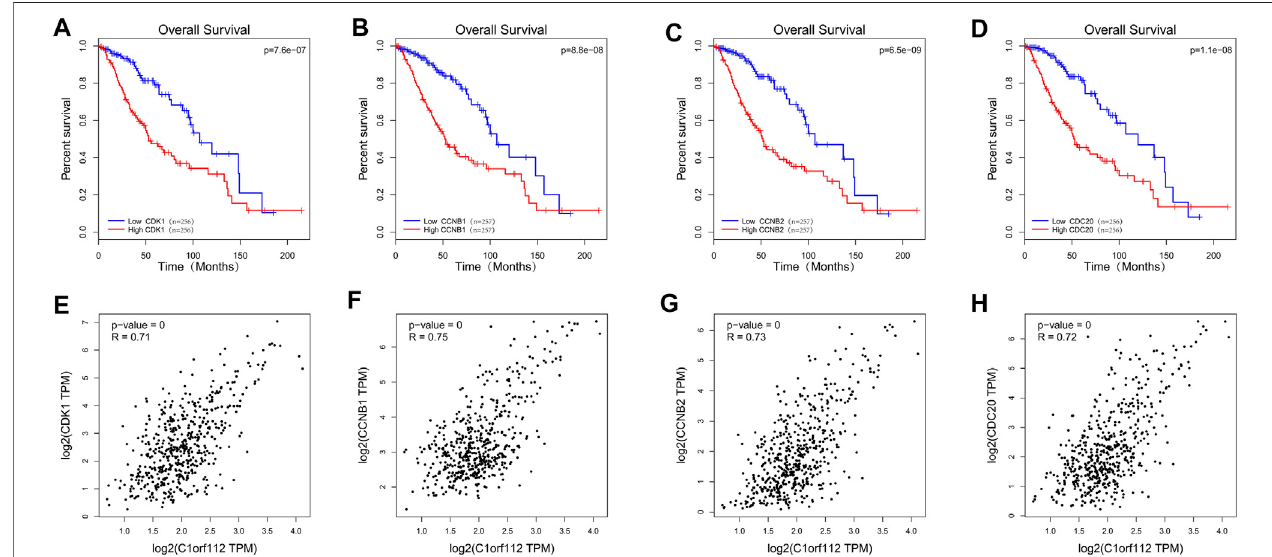
FIGURE 7 | The TCGA database was used to analyze the prognostic value and correlation of co-expressed genes. Survival curves of OS: (A) CDK1; (B) CCNB1; (C) CCNB2; (D) CDC20. Correlation between C1ORF112 and key co-expressed genes: (E) CDK1; (F) CCNB1; (G) CCNB2; (H) CDC20.